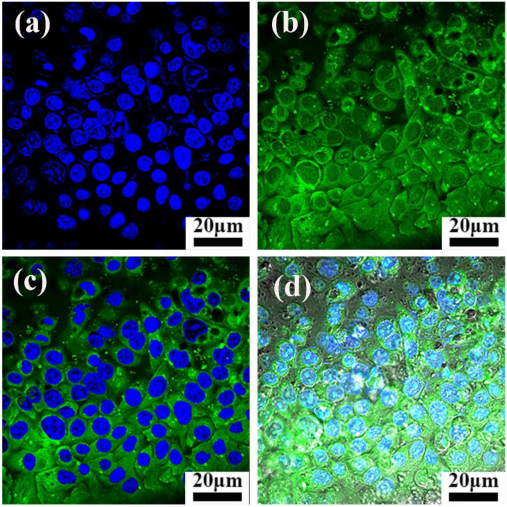
Figure 7. Confocal laser scanning microscopic (CLSM) image of 4T1 cells co-incubated with ( a ) Blue fluorescence from cell nuclei stained with 4 (cid:48) , 6 (cid:48) -diamidino- 2 -phenylindole (DAPI); ( b ) Green fluorescence from FPO@HMSNs-PAA-FITC; ( c ) Merged image; and, ( d ) Bright field image of